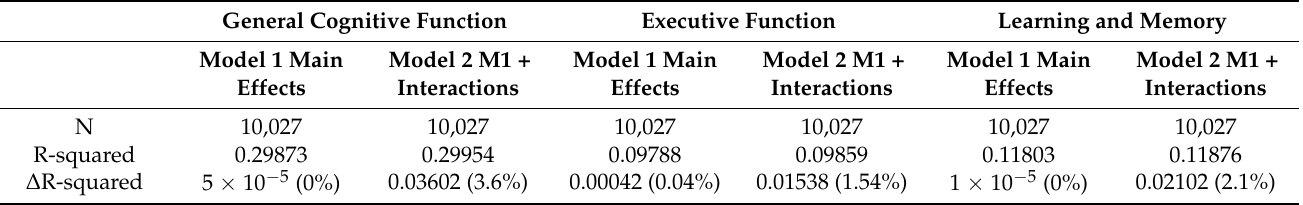
Table 2. Model fit.